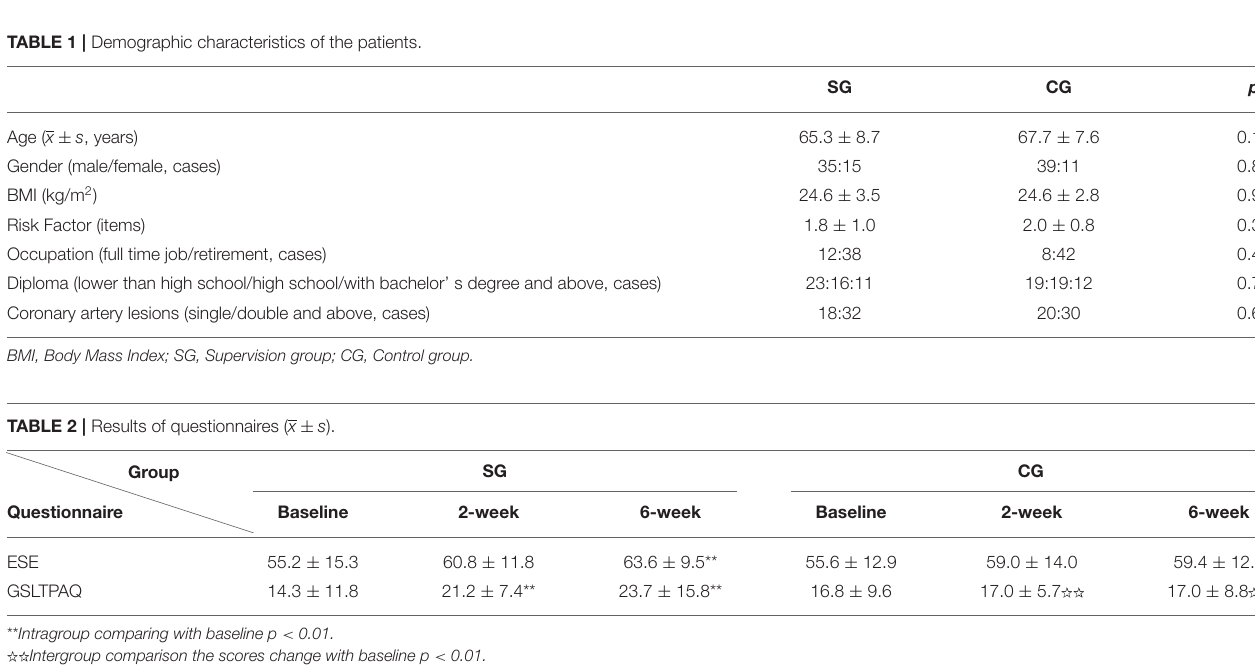
FIGURE 1 | Study design and experiment flowchart. SG, Supervision group; CG, Control group.